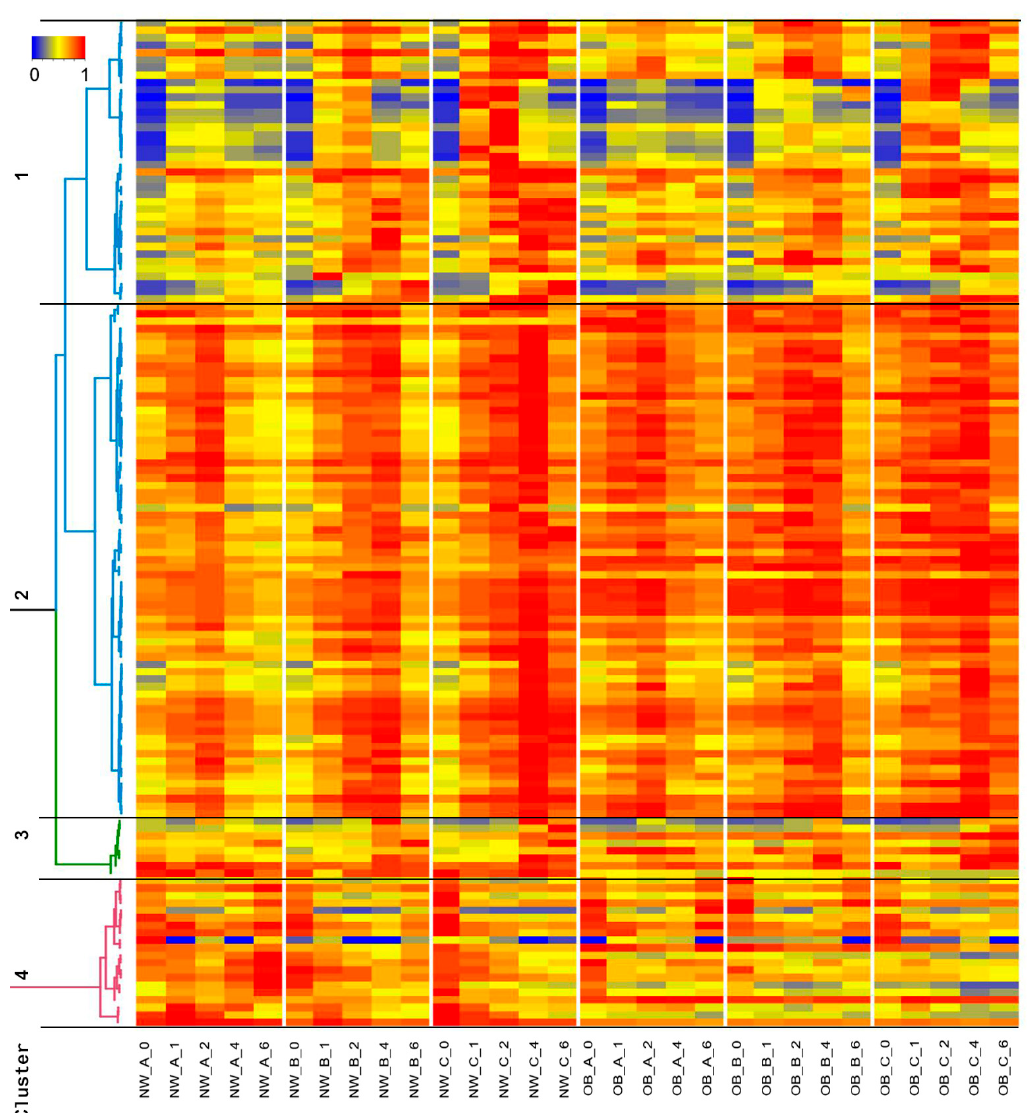
Figure 2. Clustering of postprandial kinetics (0, 1, 2, 4, 6 h) of 135 dose-dependent features in 15 normal (NW) and 17 obese (OB) men after consumption of three caloric doses of HF meals (A = 500, B = 1000, C = 1500 kcal). Median values for all groups and each feature are shown.